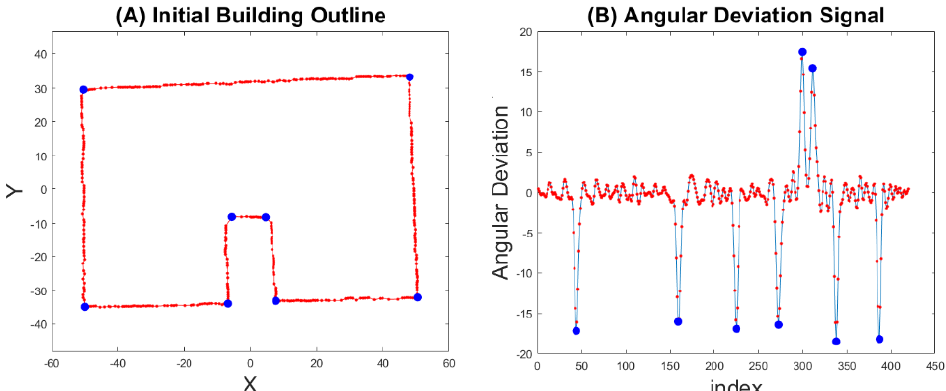
Figure 10. The result of clustering. The Y-coordinate of each dot is the normalized nonlinear indicator. X-coordinate represents the normalized angular accumulation.